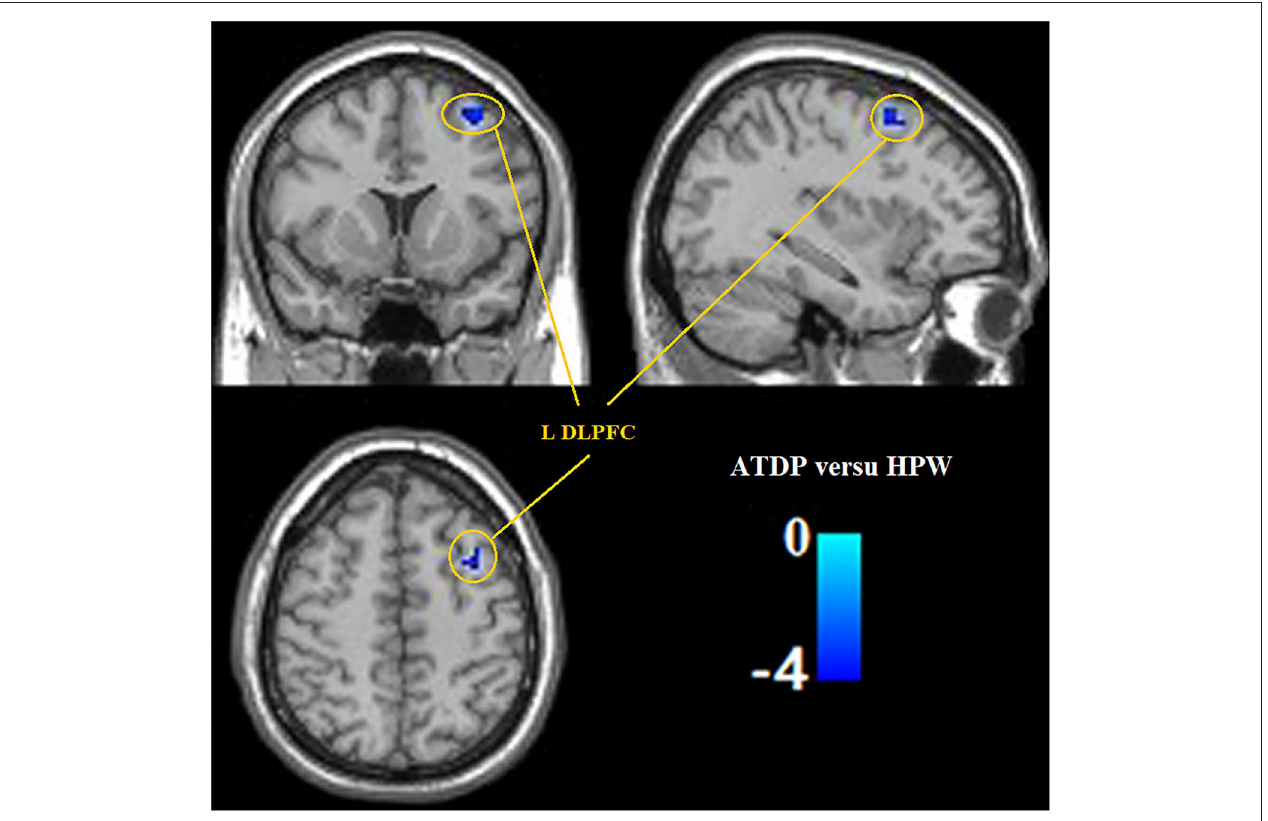
FIGURE 1 | Compared with HPW, ANDP patients showed decreased ReHo in the left DLPFC. Blue to green indicates the regions that exhibit decreased ReHo in ANDP ( p < 0.05, FDR-corrected). ANDP, Antenatal depression; DLPFC, dorsolateral prefrontal cortex; HPW, healthy pregnant women; ReHo, regional homogeneity; L, left side.